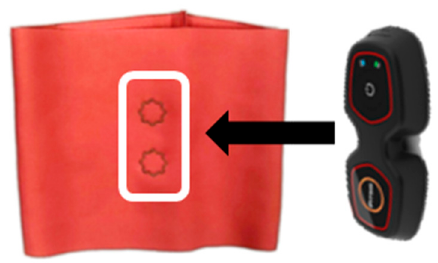
Figure 5. Images for measuring the sEMG signal using a wearable device: Measured by attaching a wearable device on top of the embroidery electrode in the white box.